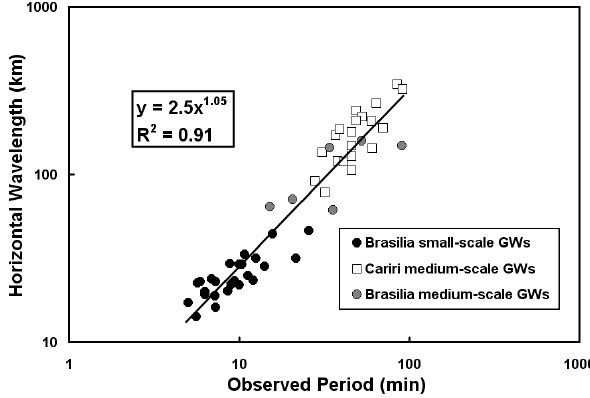
Fig. 8. Log-log plot showing the horizontal wavelength versus ob- served period. The data comprise the Brasilia and Cariri medium- scale waves and the Brasilia small-scale waves. The strait line shows the best fit to the data and agrees well with previous radar and optical studies of Reid